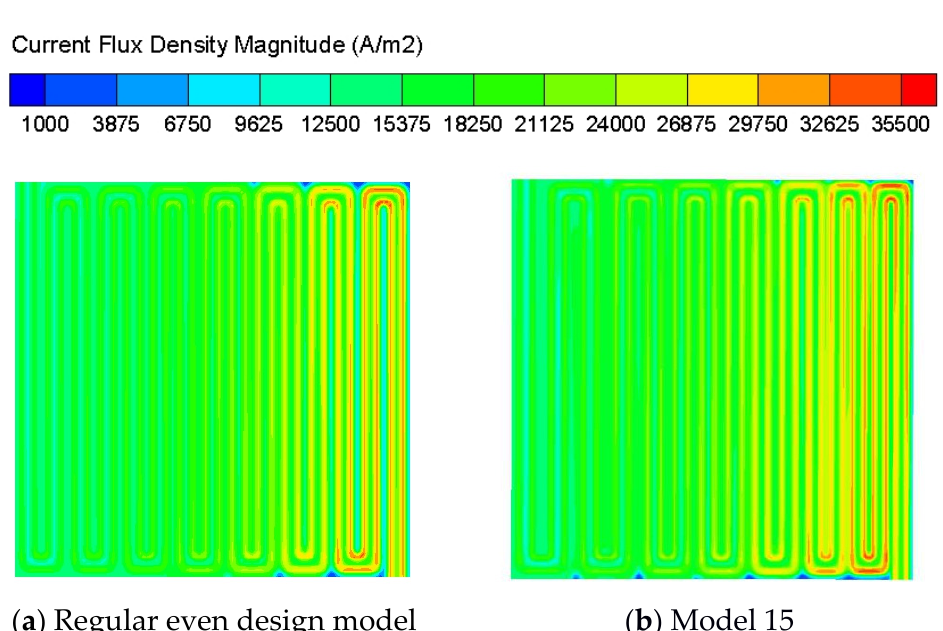
Figure 5. Current density distribution on the cathode catalyst layer.